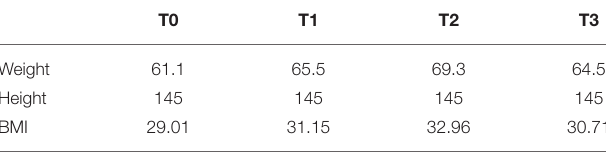
TABLE 1 | Anthropometric